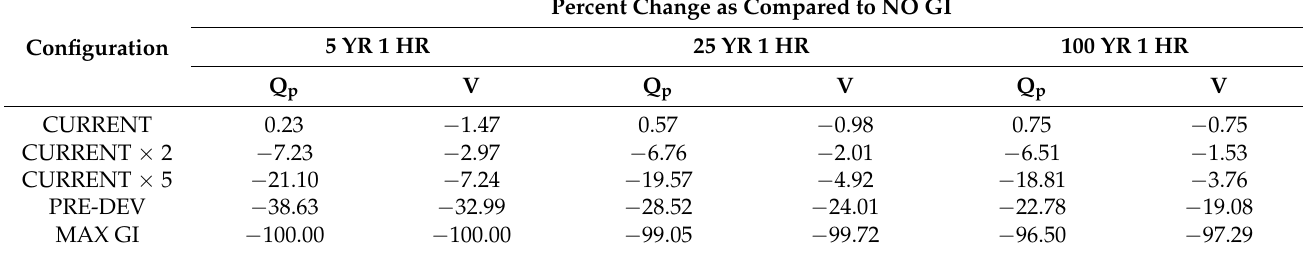
Table 3. Percent change in peak flow (Q p ) and runoff volume (V) at the watershed outlet as compared to the NO GI configuration for the 3 design storm